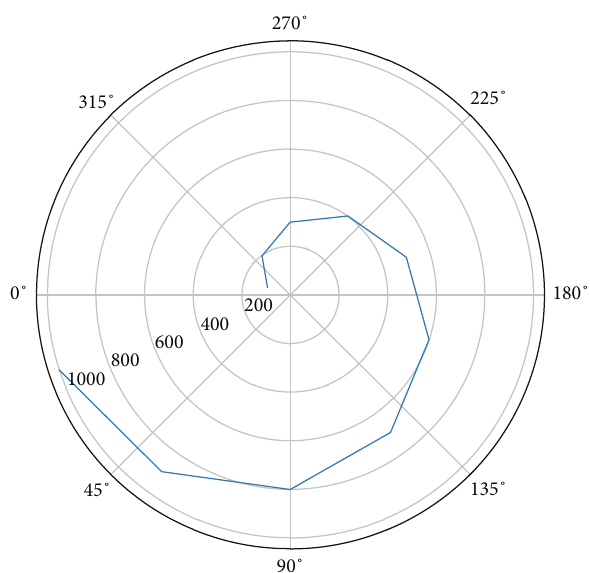
Figure 8: Factor analysis of teacher burnout